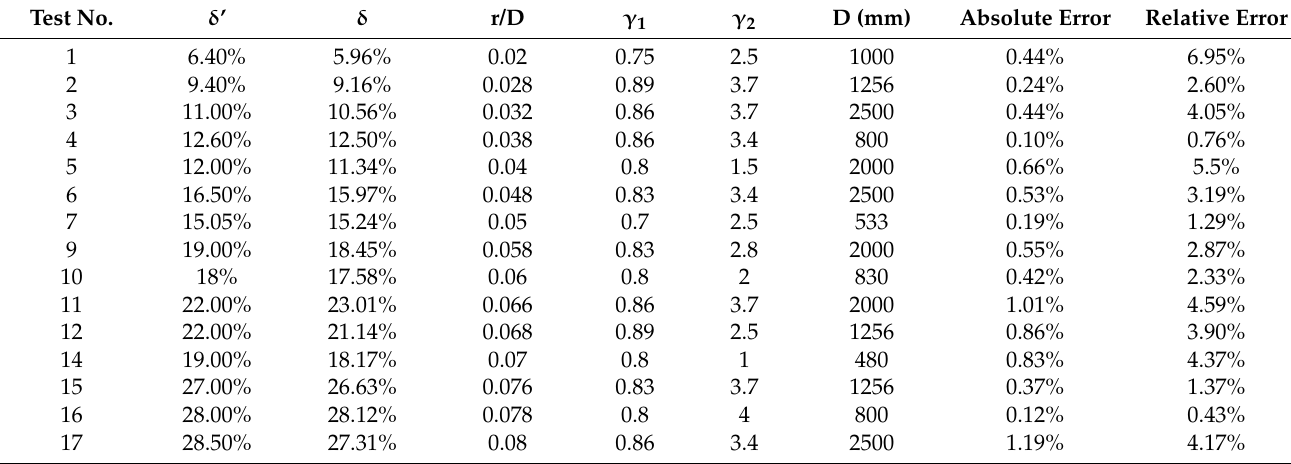
Table 9. Accuracy test of formula for the relative wall thickness